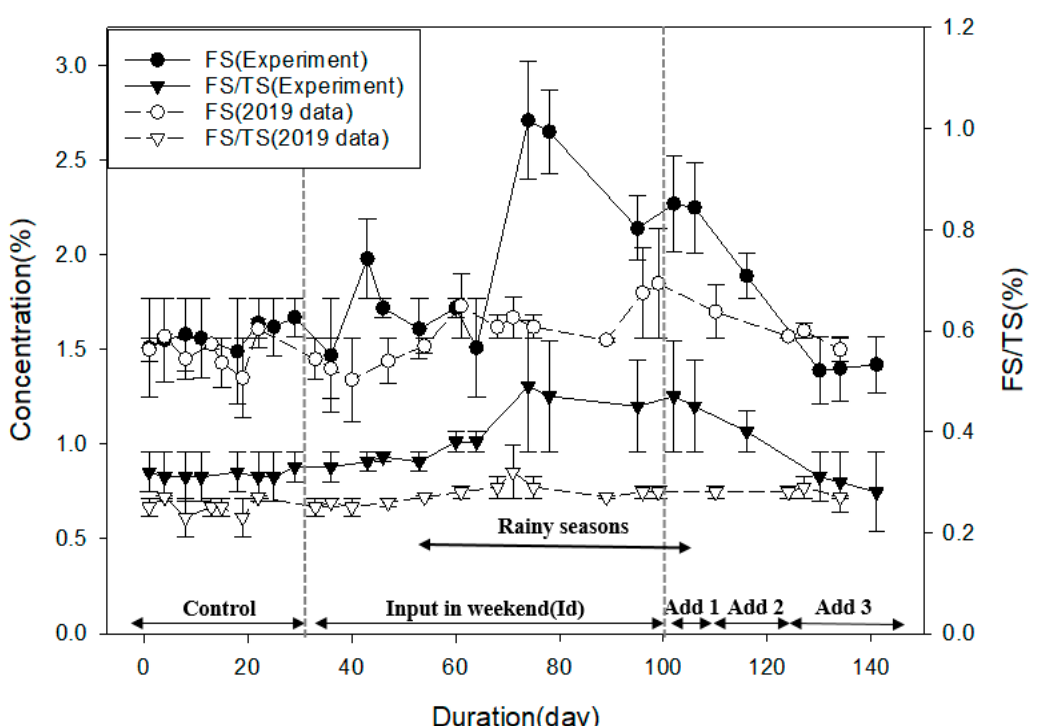
Figure 6. Line graph depicting the variation in FS and FS/TS concentrations in the experimental period.